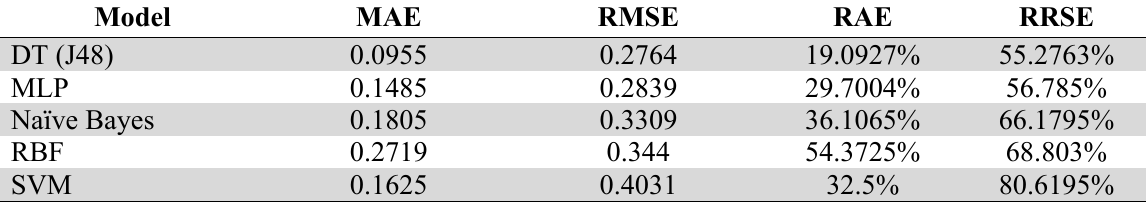
Performance statistics of different ML-based models